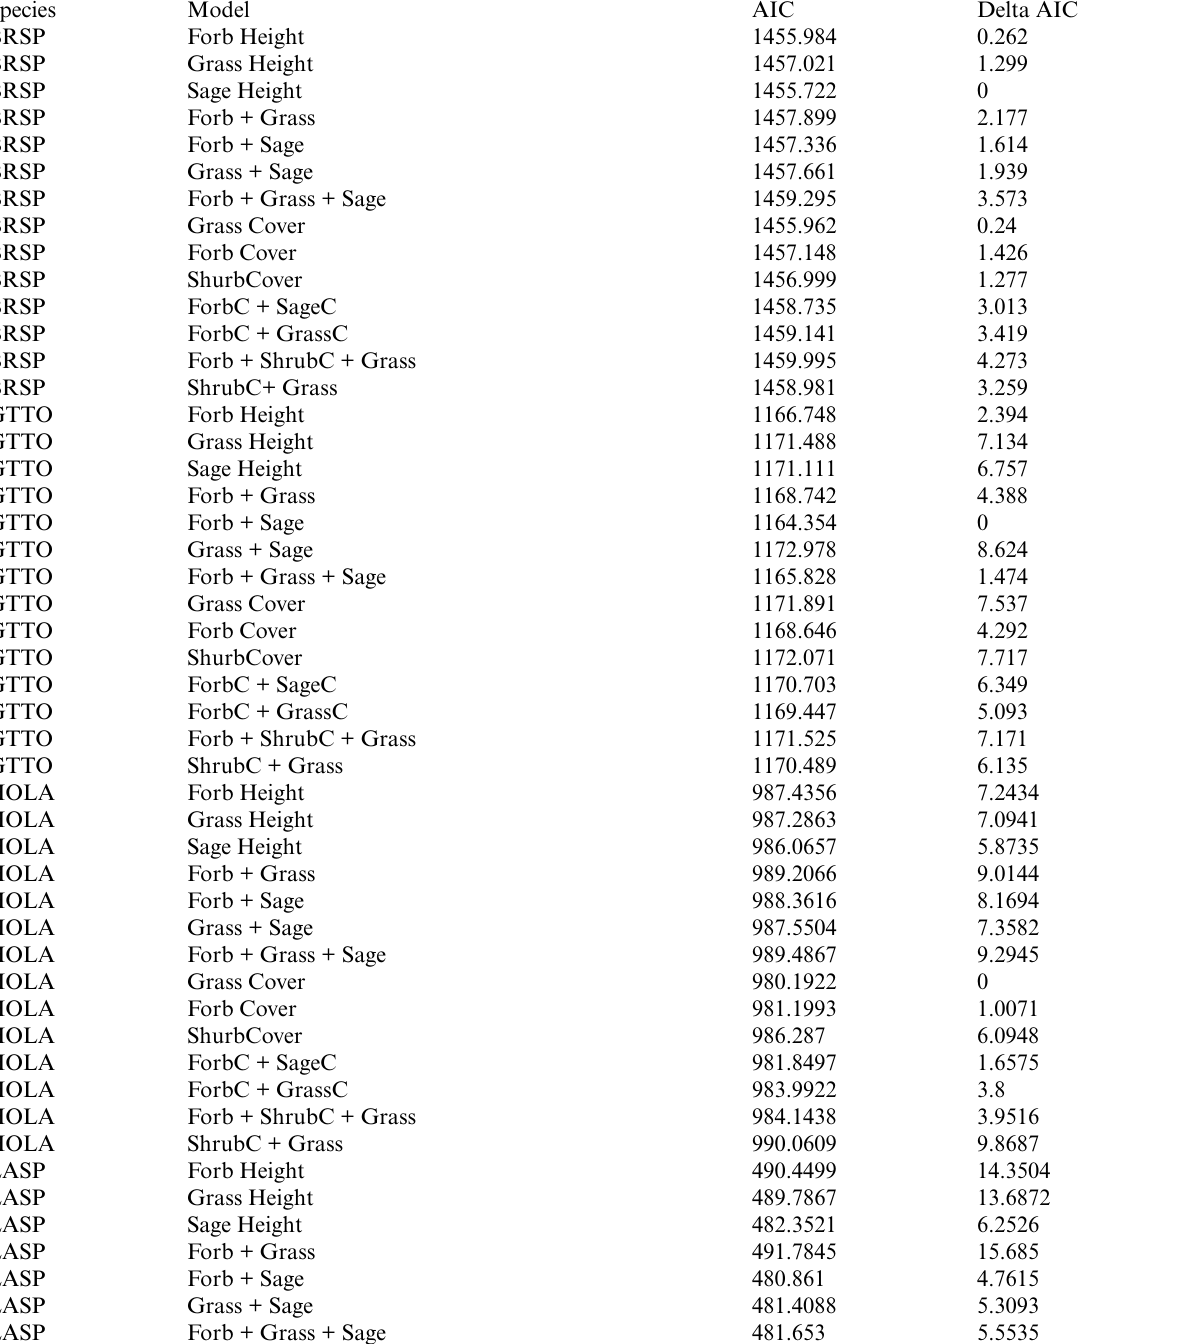
APPENDIX 1 . Model selection results for habitat relationships for eight sagebrush associated songbirds in western Colorado. Bird species are Brewer’s Sparrow (BRSP), Green-tailed Towhee (GTTO), Horned Lark (HOLA), Lark Sparrow (LASP), Sage Sparrow (SAGS), Sage Thrasher (SATH), Vesper Sparrow (VESP), and Western Meadowlark (WEME). Parameter estimates for the AIC selected best model are provided in Table